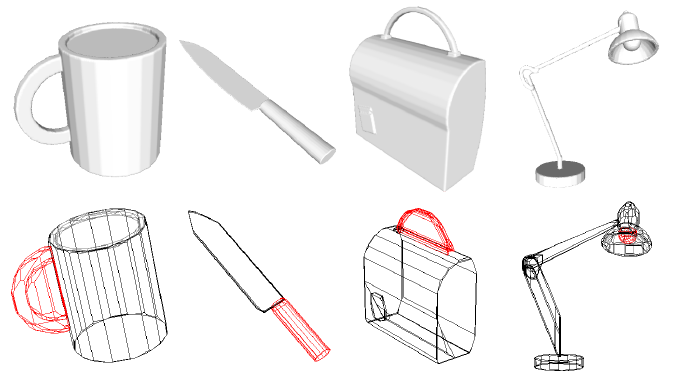
Figure 3. Representation of objects by convex template instances